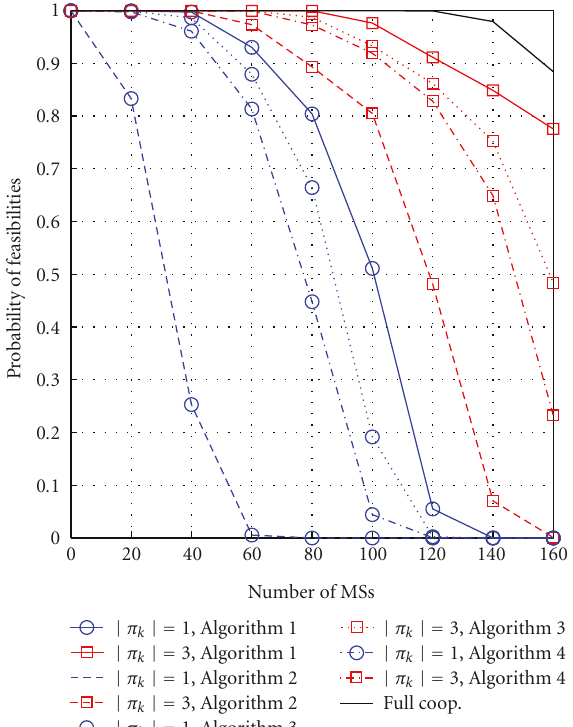
Figure 2: Comparison of probabilities of feasibility versus the number of MSs with the SINR constraint of 0dB.